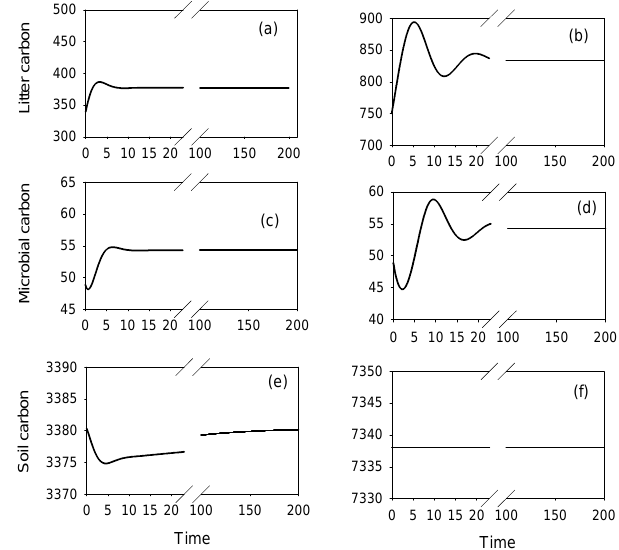
Figure 2. Dynamics of litter carbon (a, b) , microbial carbon (c, d) , and soil carbon (e, f) for model A (a, c, e) and model B (b, d, f) after a 10% reduction of initial pool size in litter and microbial carbon. The unit is gCm − 2 for carbon pool on the y axis and year for time. All initial pools are steady-state values for a carbon input of 200gCm − 2 yr − 1 at a soil temperature is 25 ◦